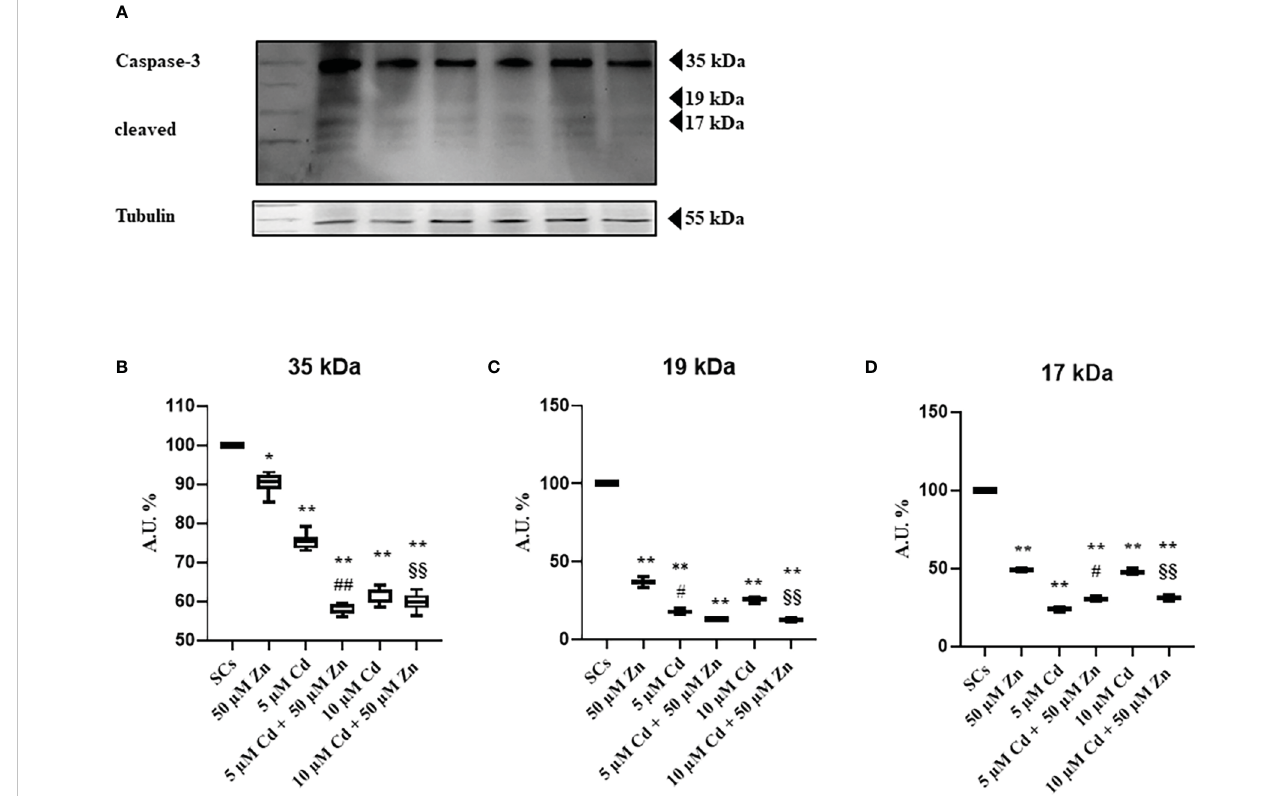
FIGURE 3 WB analysis of apoptosis. (A) Immunoblots of caspase-3 p35, p19, and p17 in the absence (unexposed-control group, SCs) or presence of 5 or 10 m M CdCl 2 and/or 50 µM ZnCl 2 for 48 h. Densitometric analysis of the protein bands of caspase-3 p35 (B) , p19 (C) , and p17 (D) in the absence (unexposed- control group, SCs) or presence of 5 or 10 µM CdCl 2 and/or 50 µM ZnCl 2 for 48 h. Data presented as the mean ± SEM (* p < 0.05 and ** p < 0.001 vs . SCs, # p < 0.05 and ## p < 0.001 vs . 5 µM Cd, §§ p < 0.001 vs . 10 m M of three independent experiments, each performed in